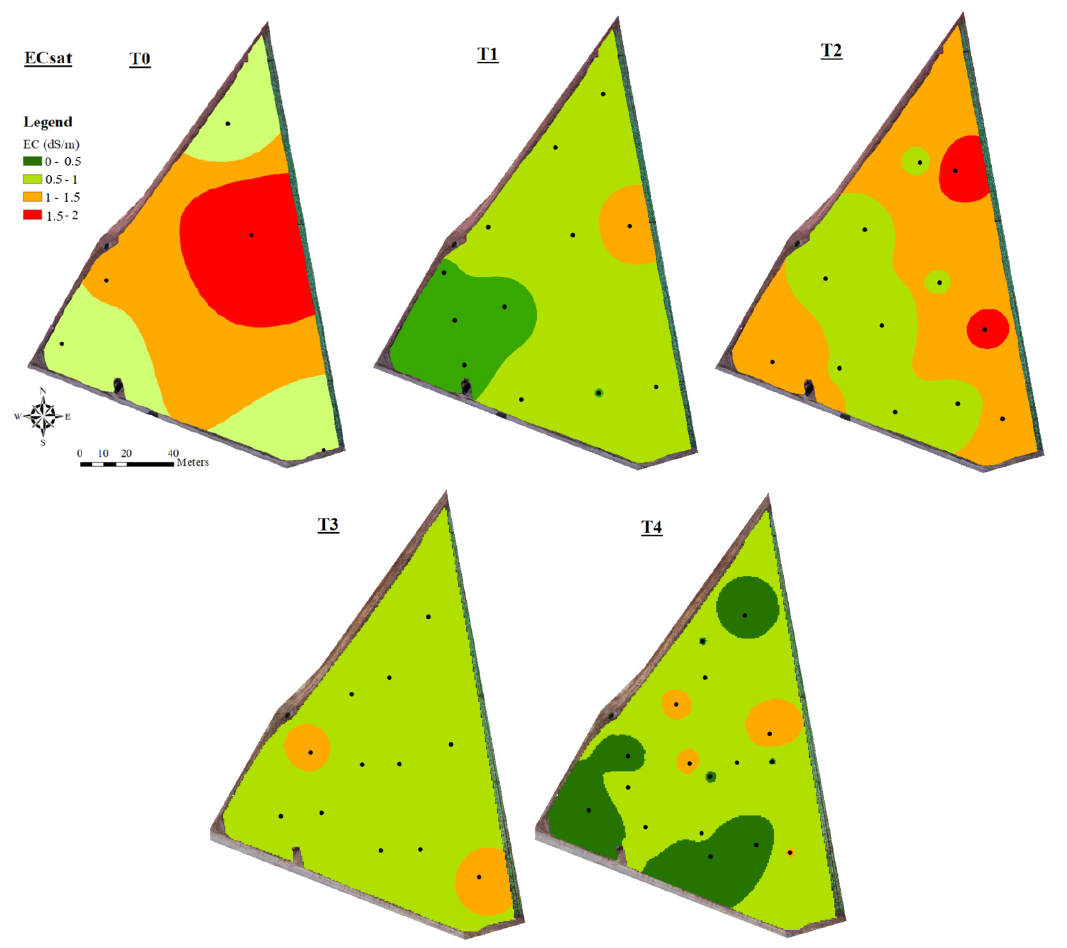
Figure 7. Maps showing the electrical conductivity of the soil (ECsat) for samples from T0, T1, T2, T3, and T4, with black dots indicating the positions of the soil samples.